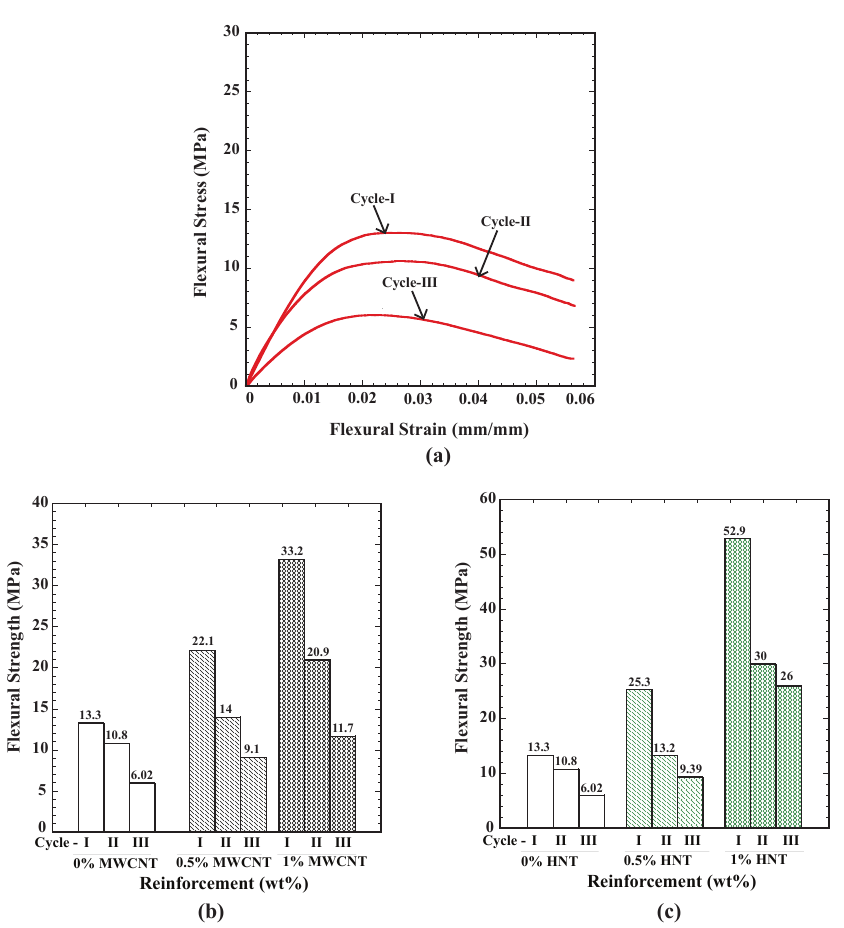
Figure 7. ( a ) Flexural stress vs. flexural strain for pure SMPU 4D-printed specimen for three cycles; ( b ) flexural strength for three cycles of SMPU specimens reinforced in MWCNTs; ( c ) flexural strength for three cycles of SMPU specimens reinforced with